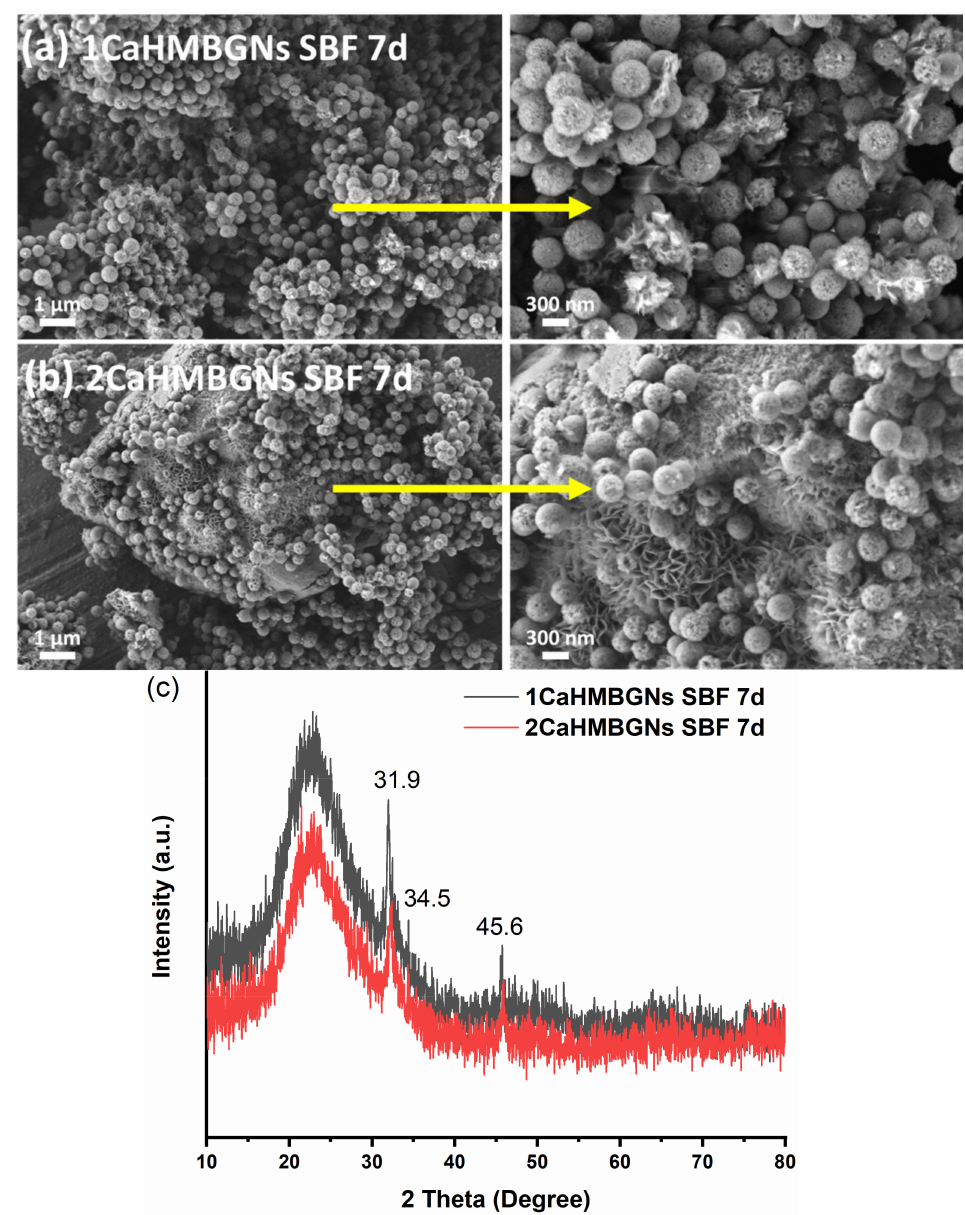
Figure 7. In-vitro hydroxyapatite formation of HMBGNs; ( a , b ) SEM images of 1CaHMBGNs and 2CaHMBGNs after immersion in SBF for seven days; ( c ) XRD patterns of HMBGNs after immersion in SBF for seven days. The marked peaks at 2 θ = 31.9 ◦ , 34.5 ◦ , and 45.6 ◦ corresponded to HA peaks (JCPD 84-1998)